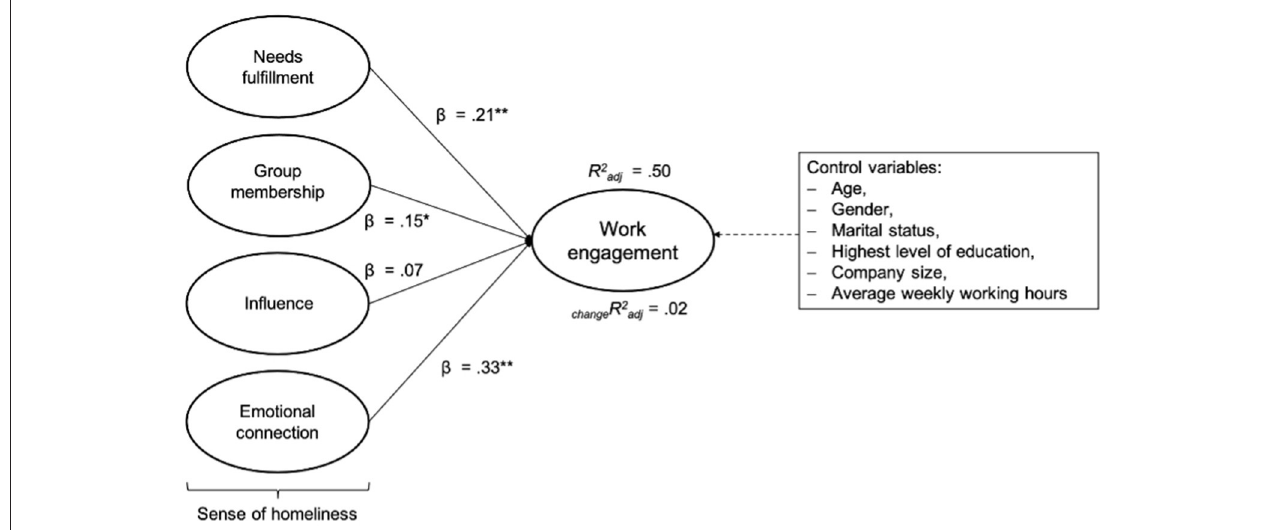
FIGURE 4 | Multiple regression analysis with the total burnout score as a dependent variable and NF, GM, IN, and EC as independent variables (step 1); change R 2 adj after incorporating the control variables (step 2) R 2 adj = R 2 adjusted; change R 2 adj = change in R 2 adjusted; * p < 0.05; ** p <